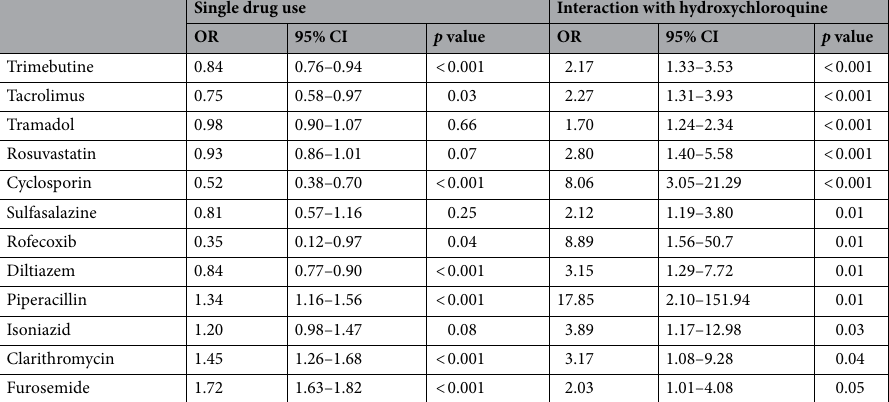
Table 2. Odds ratio of single drug use and interaction with hydroxychloroquine from each multiple logistic regression. Detailed analysis results of 12 drugs whose interaction term with hydroxychloroquine was statistically significant ( p > 0.05 ) in linear regression. ‘Single drug use’ columns show the Odds ratio (OR), 95% Confidence interval (95% CI), and p value of the analyzed drug in the linear regression, and ’Interaction with hydroxychloroquine’ columns show OR, 95% CI, and the p value of the interaction term with hydroxychloroquine. p value was calculated through the two-sided T